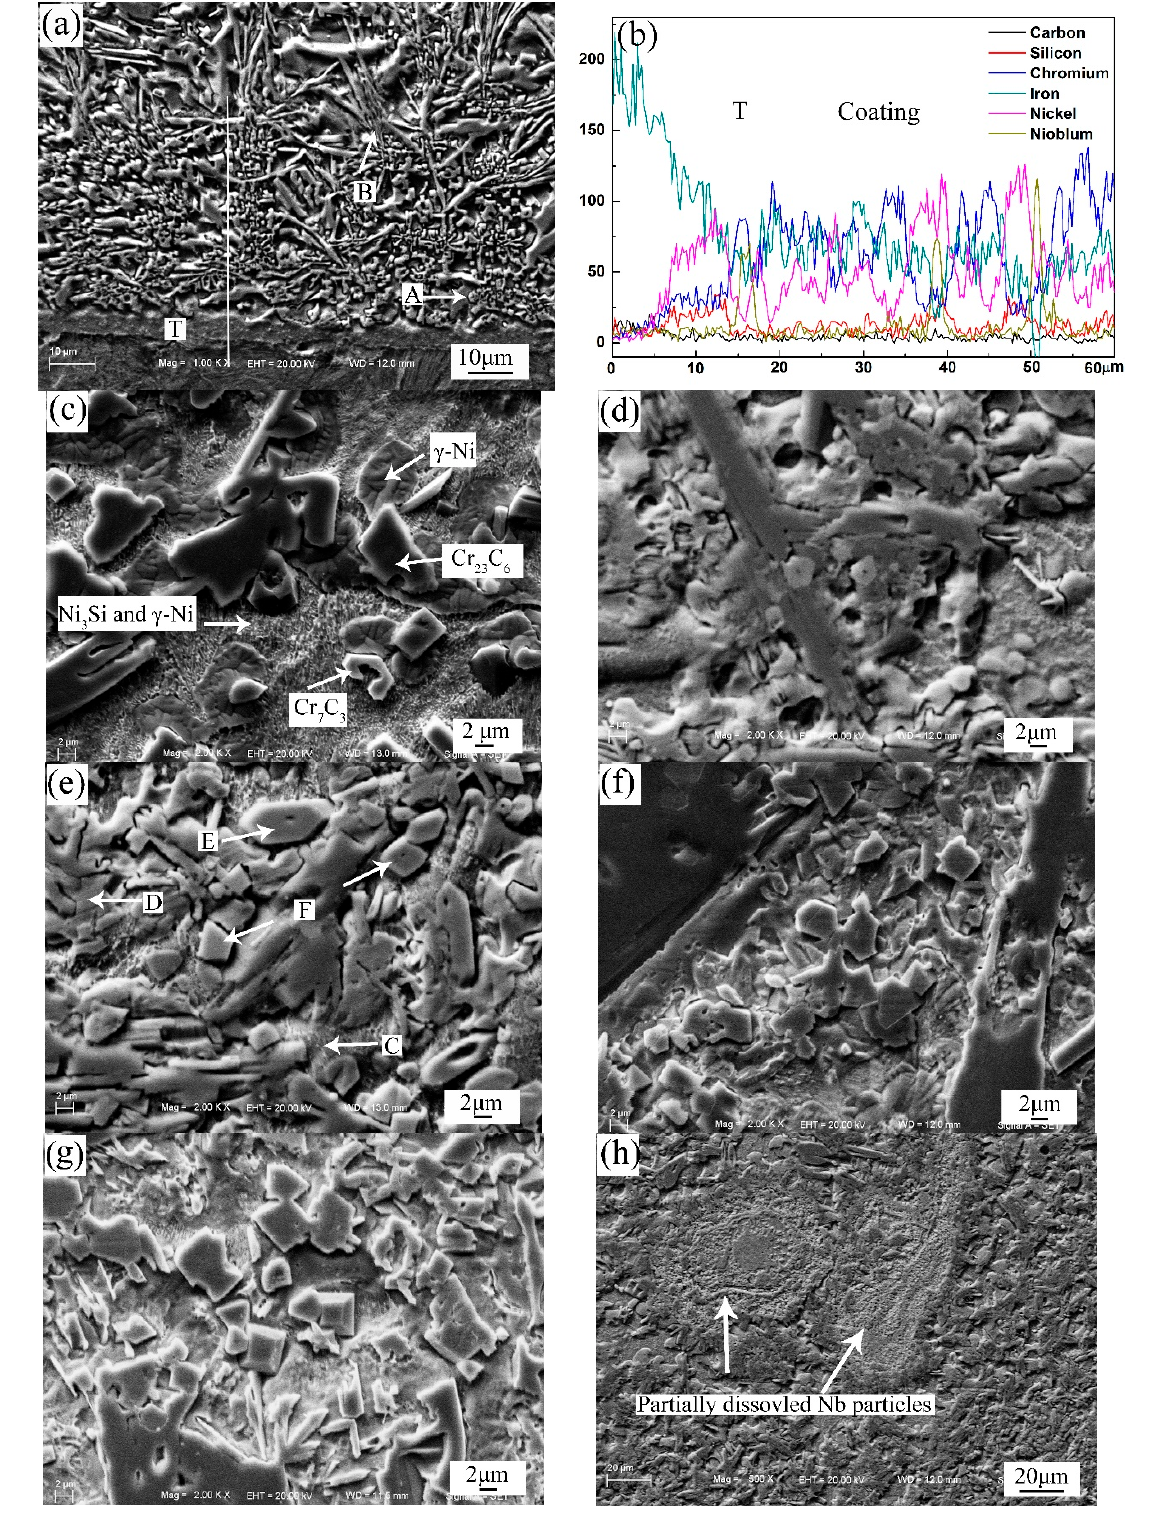
Figure 4. SEM microstructures of the coatings ( a ) coating with P1 near the fusion line, ( b ) energy spectrum analyzer (EDS) results, ( c ) coating with P0, ( d ) coating with P1, ( e ) coating with P2, ( f ) coating with P3, ( g ) coating with P4, and ( h ) coating with P5.